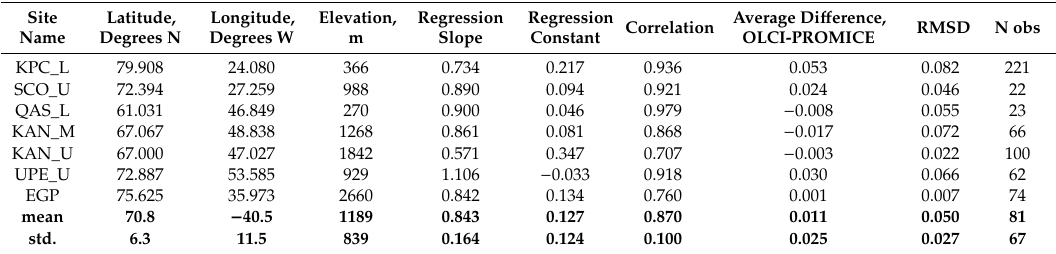
Table 4. Broadband albedo comparison statistics between OLCI and Greenland ice sheet PROMICE